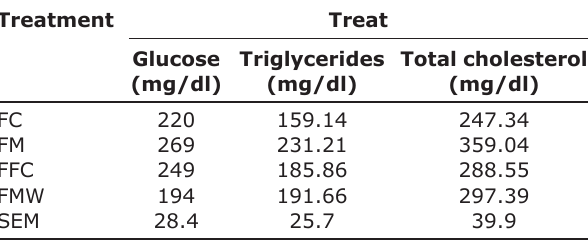
Table-5: Biochemical parameters mean (±SEM) of Ross 40 broilers fed with different agroindustrial waste sampled from postnatal 1 st -6 th weeks*.